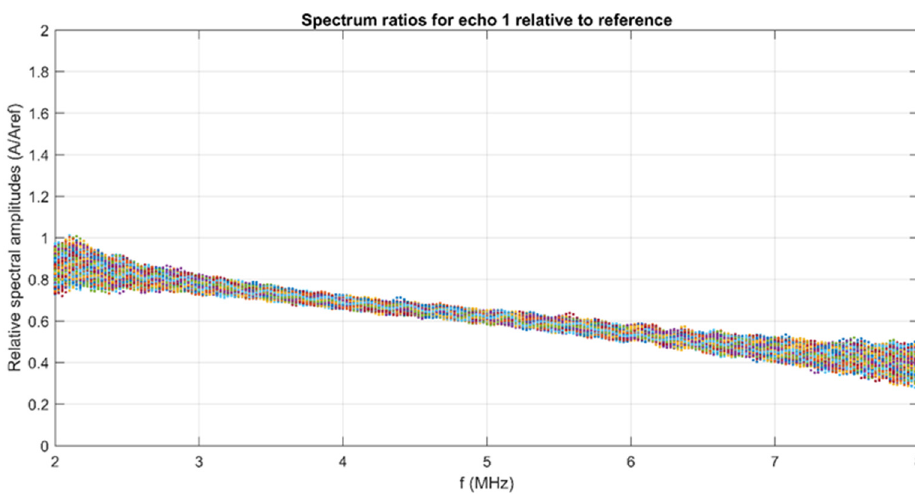
Figure 2. Relative spectral amplitudes of the tested samples.